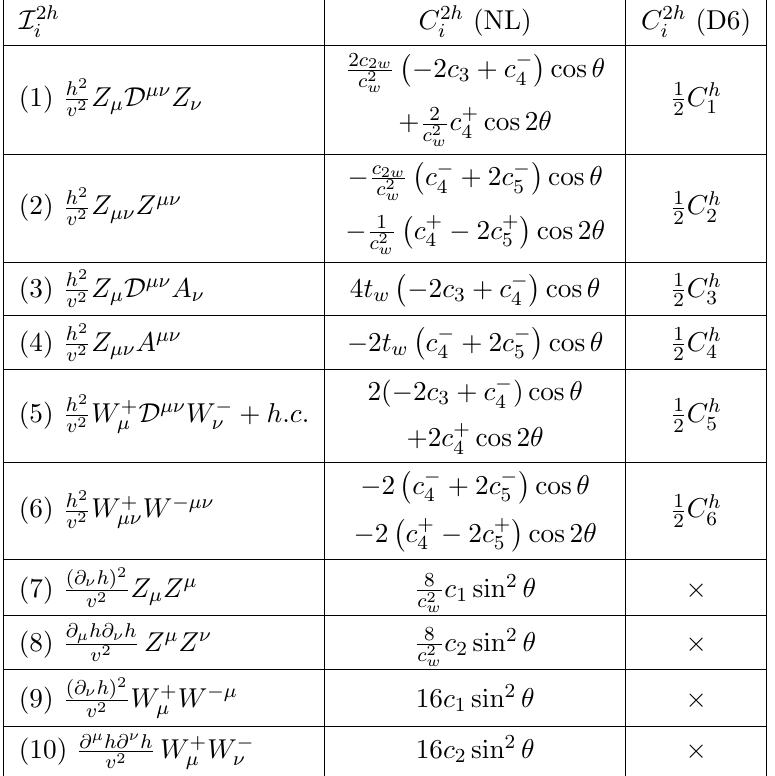
involve two Higgs bosons for universal nonlinearity case i ) means there is no contribution at (cid:2) = C h = 2 for SMEFT at the dimension-6 level. i i